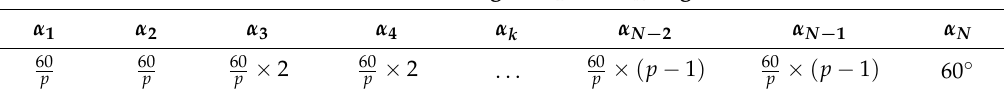
Table 3. Generalized initialization procedure for SHEM angle sets. ( N can be chosen to be any value among 3, 5, 7, . . . , 17; N = 17 eliminates all odd-order characteristic power system harmonics up to the